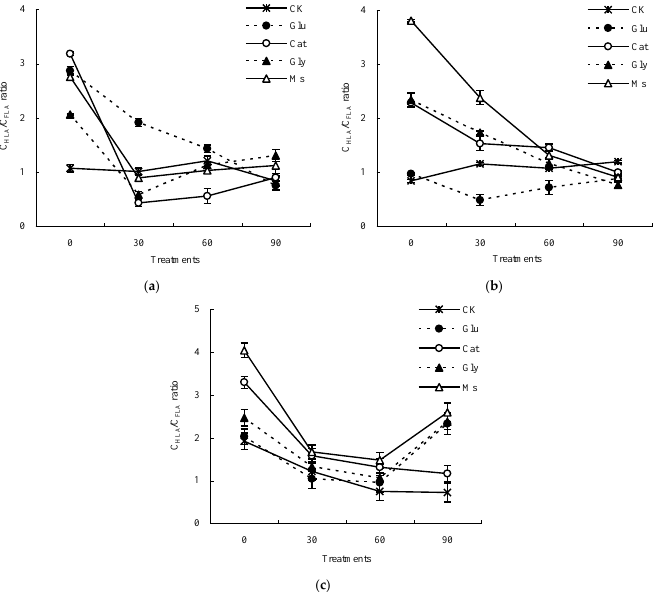
Figure 2. Effect of Maillard reaction precursors on the C HLA /C FLA ratio of the decomposing material of rice straw at three incubation temperatures. ( a ) Incubated at 10 °C; ( b ) incubated at 15 °C; ( c ) incubated at 28 °C.